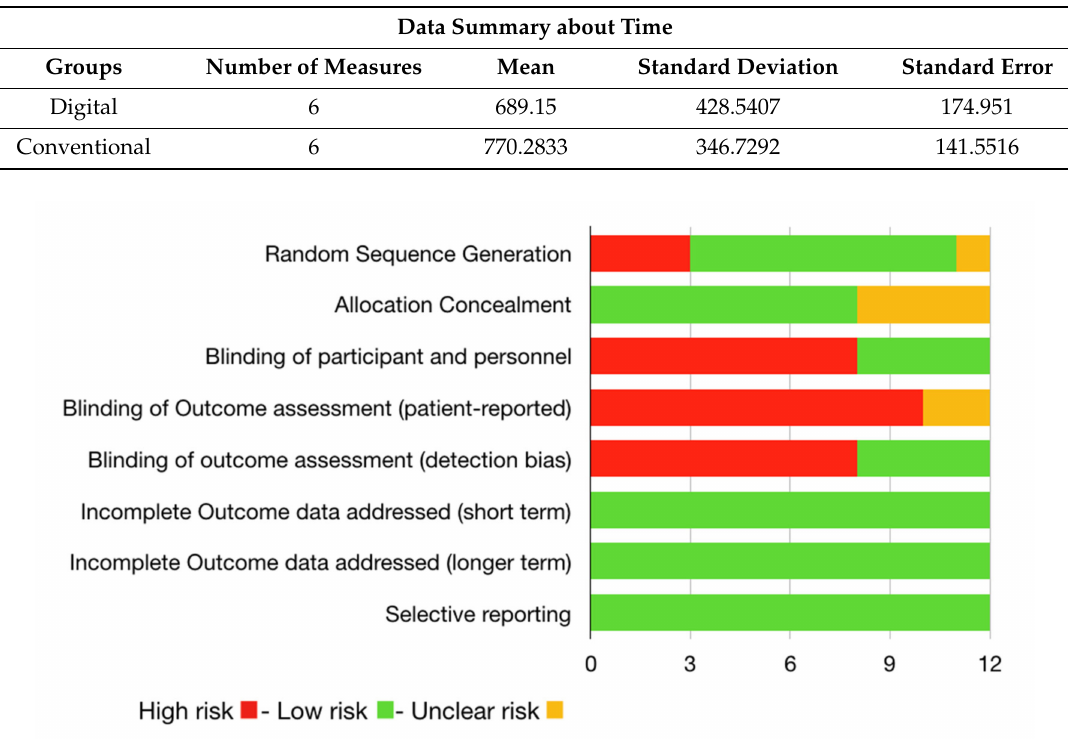
Table 6. Analysis of Variance.